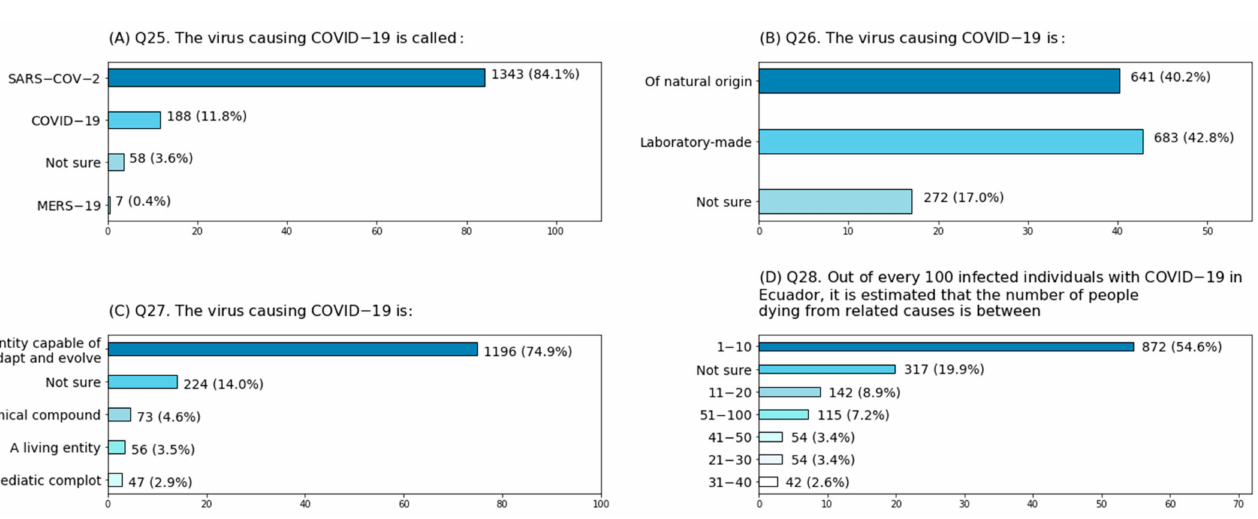
Figure 2. Response percentages for multiple-option questions. ( A ) Question 25; ( B ) Question 26; ( C ) Question 27; ( D ) Ques- tion